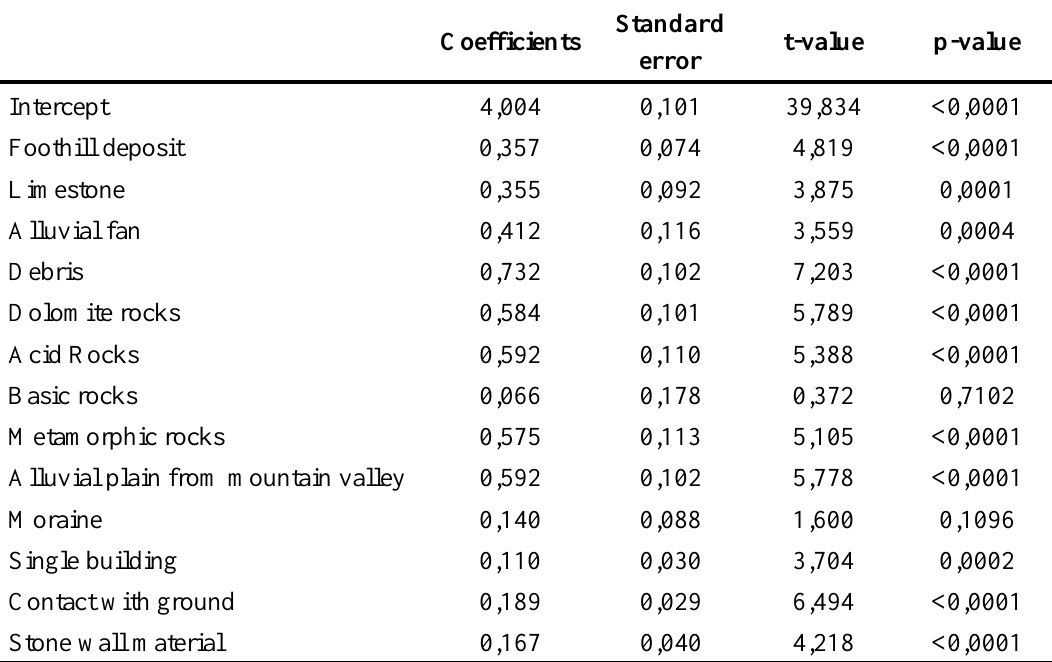
Table 5. Estimated coefficients of GLS model. Alluvial plain is the geologic baseline category [47].